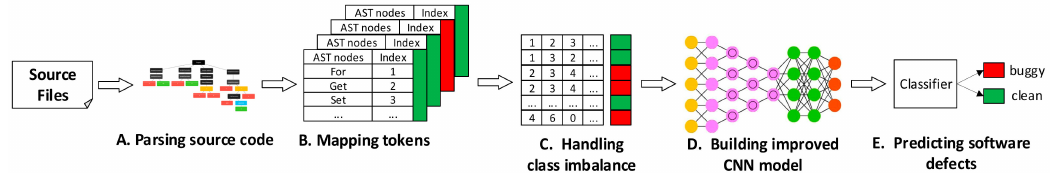
Figure 5. The overall workflow of a software defect prediction based on our improved CNN model.